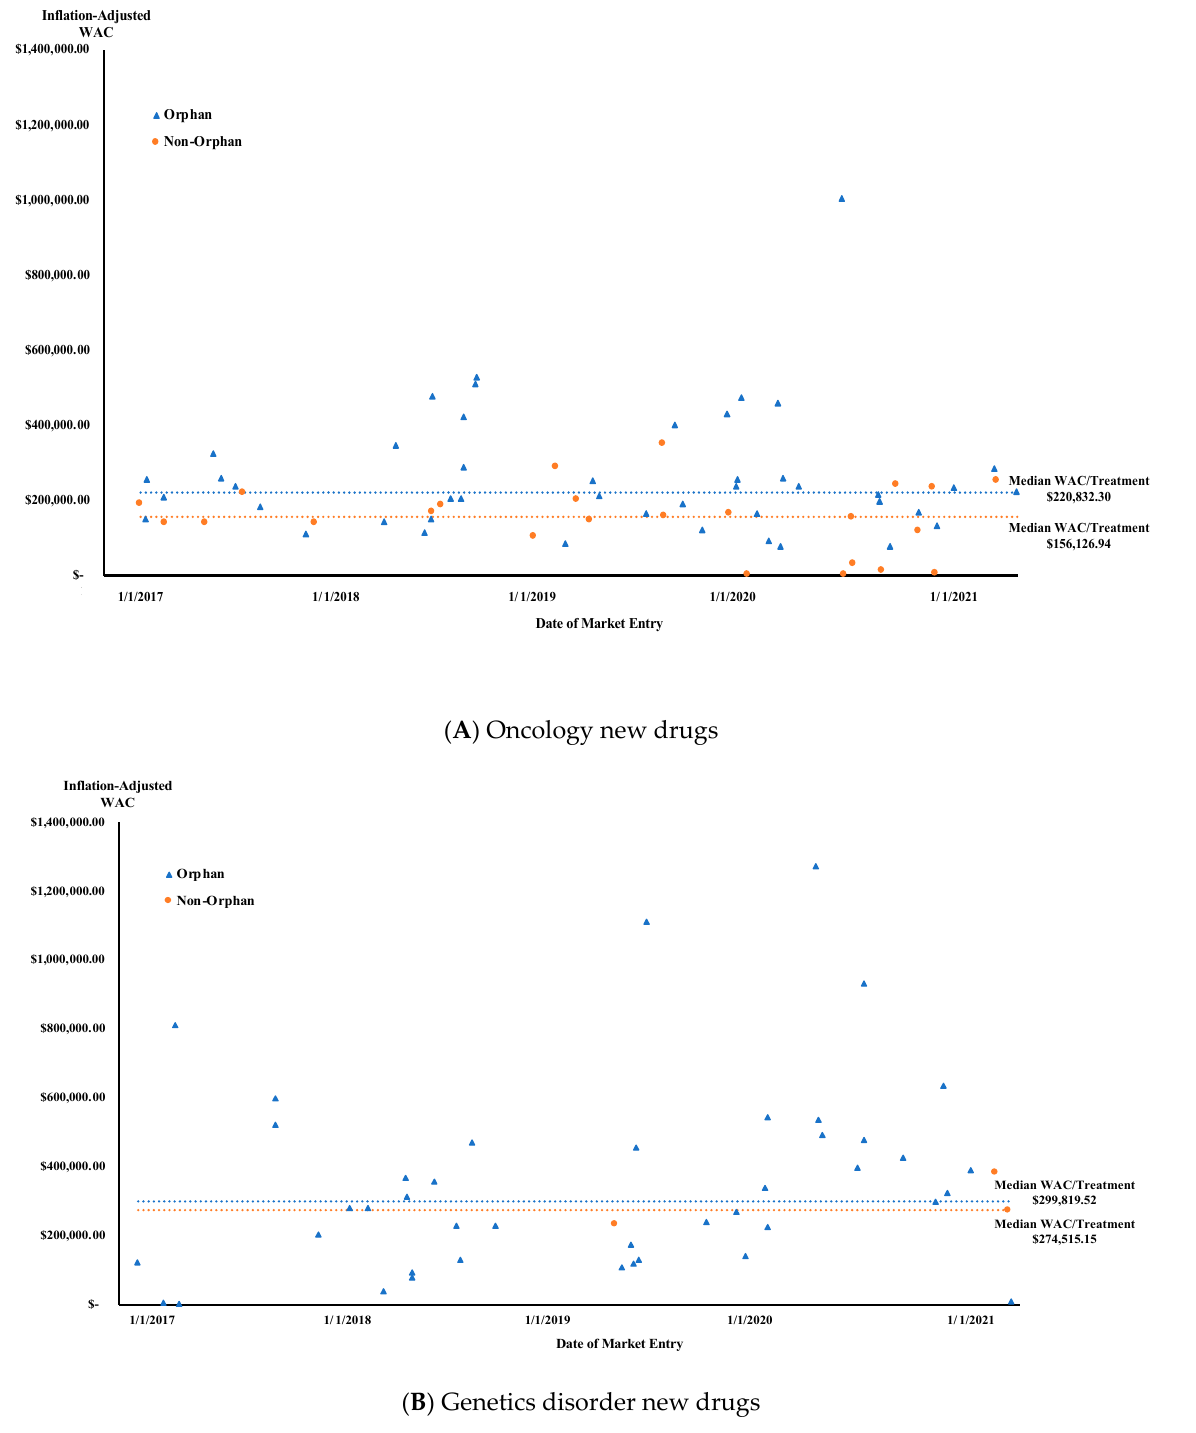
Figure A2. New drugs treatment cost at US market entry (USD 2021) and median WAC.